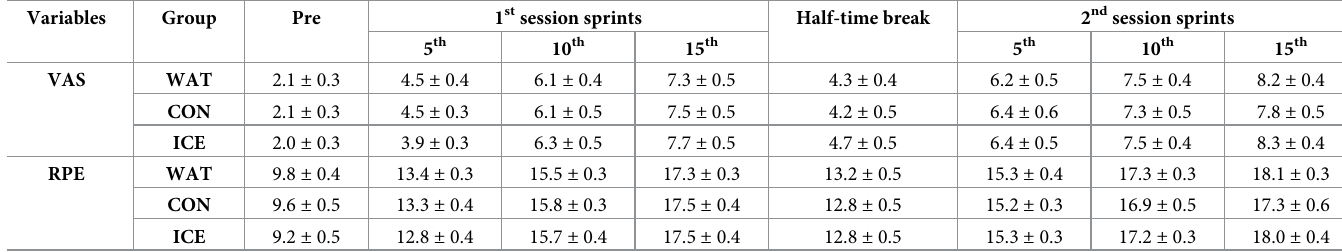
Table 2. Subjective fatigue.